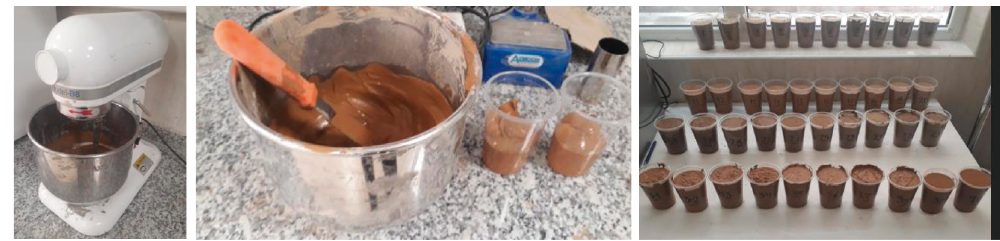
Figure 6: Mixing of stabilizing materials in